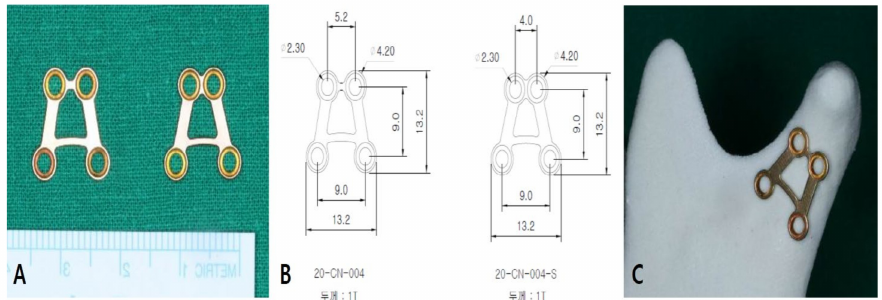
Figure 1. Trapezium plate shape and dimensions. ( A ) Two subtypes of trapezium plate. ( B ) Numerical description of each trapezium plate. ( C ) Trapezium plate applied to a rapid prototype